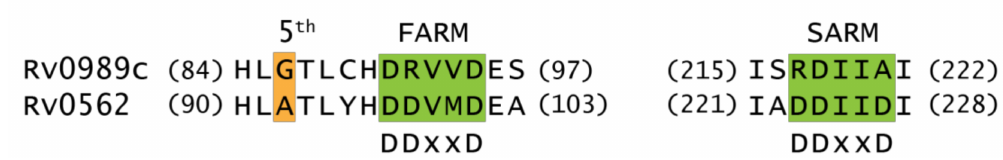
Figure 2. Partial protein sequence alignment of Rv0989c and Rv0562. Rv0562 contains the canonical trans -IDS first and second aspartate-rich DDxxD motifs (FARM and SARM; highlighted in green), but these are both disrupted by Arg substitutions in Rv0989c. The fifth residue upstream of the FARM, which is typically responsible for product length determination in trans -IDS, is also highlighted here